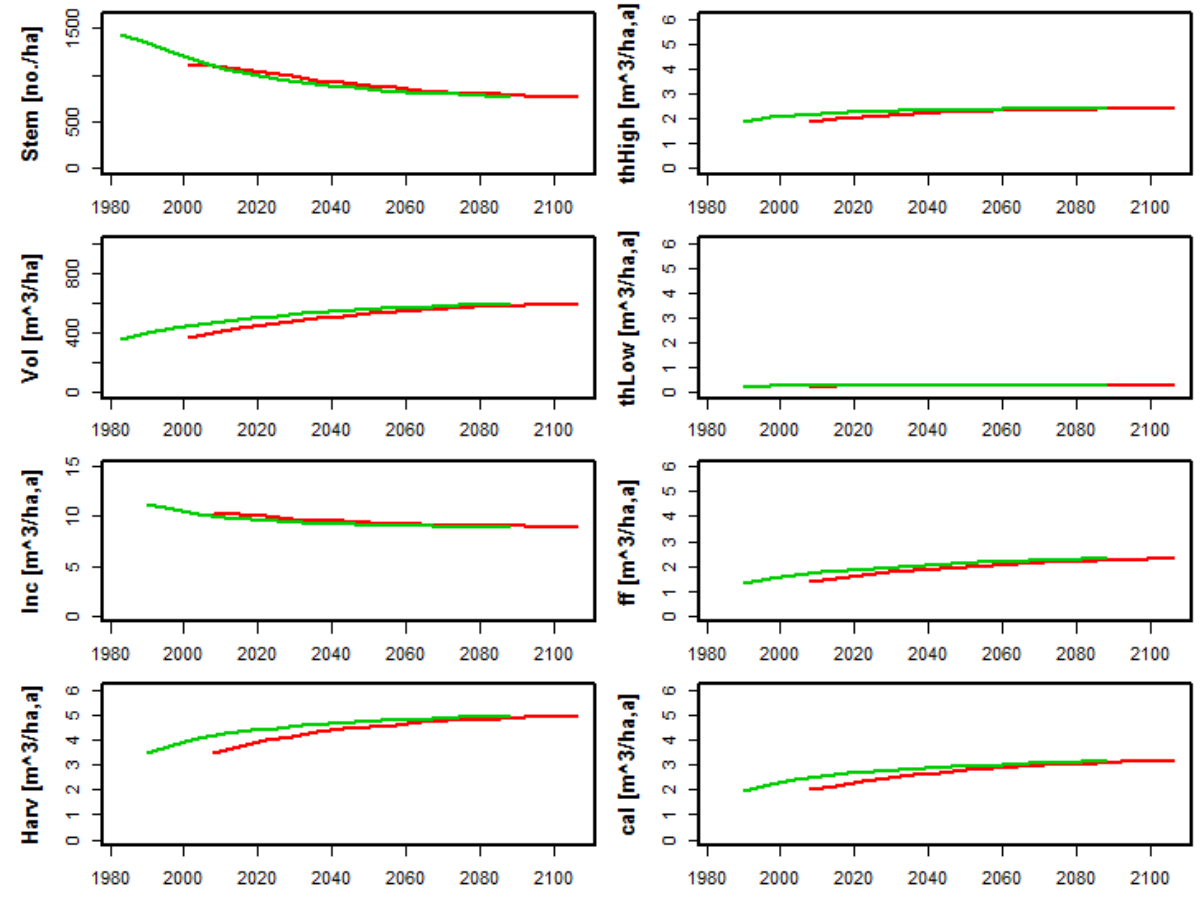
Figure 3. Development of the Norway spruce forest on elevation class 1 using 1983 (green line) and 2001 (red line) initial states,